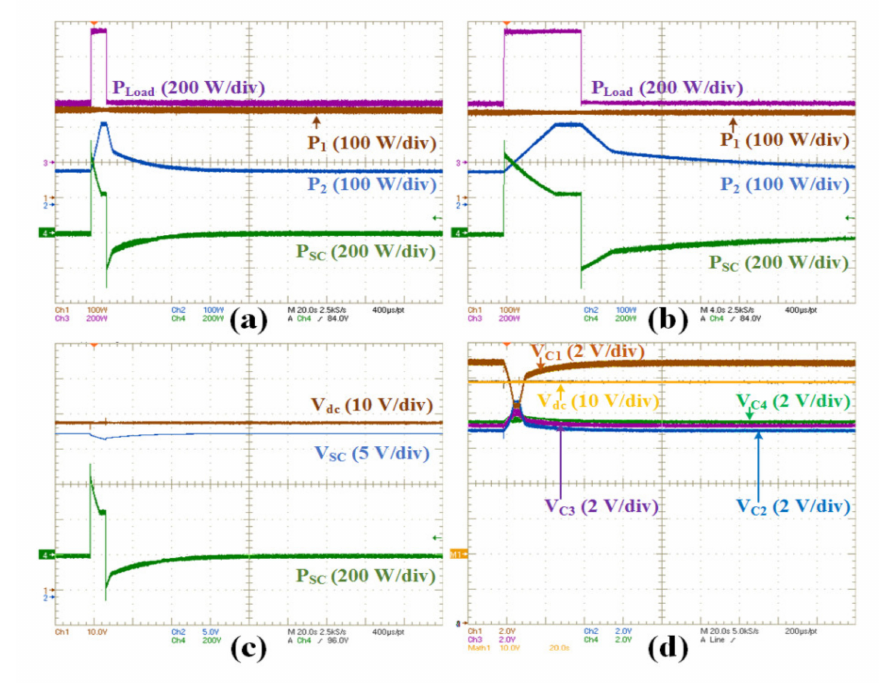
Figure 20. Experimental result of the energy management system when the stacks are in the normal condition except the first stack (drying condition) and an overload occurs: ( a ) Injected power and load power variations; ( b ) Zoom on the power; ( c ) DC link and SC voltage changes; ( d ) Output capacitor voltage